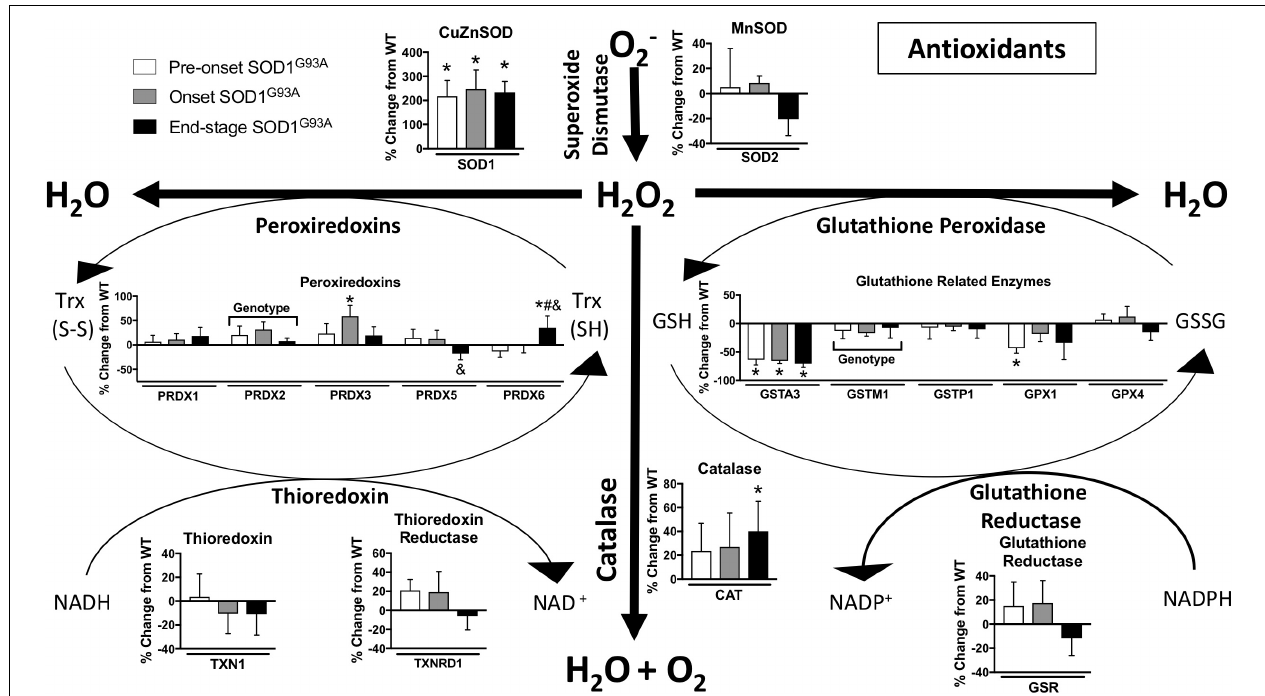
FIGURE 5 | Antioxidants. Changes in protein content of major antioxidants in SOD1 G93A spinal cords compared to controls measured by mass spectrometry ( n = 5–6). Data are represented as percent change relative to the same time point wild-type control. Bars represent means ± standard deviation. “Genotype” denotes a significant genotype effect in Benjamini-Hochberg corrected two-way ANOVA with p < 0.05 but no individual Multiple Comparison test was significant. Significance symbols demonstrate p < 0.05 for a genotype effect and additional significant results for the Tukey Multiple Comparison test. ∗ p < 0.05 wild-type vs. SOD1 G93A at the designated time point; & p < 0.05 vs. SOD1 G93A pre-onset; # p < 0.05 vs. SOD1 G93A onset. SOD1 G93A pre-onset (white), SOD1 G93A onset (gray), SOD1 G93A end-stage (black). O 2 - , superoxide; H 2 O 2 , hydrogen peroxide; GSH, reduced glutathione; GSSG, oxidized glutathione disulfide; TRX (SH), reduced thioredoxin; TRX (S-S), oxidized thioredoxin. Protein names, IDs, and absolute expression values are detailed in Supplemental Table 1